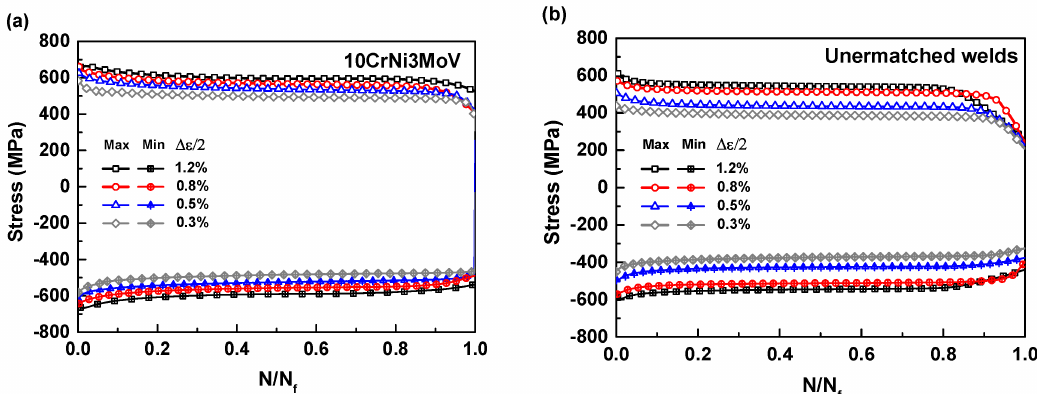
Figure 5. Evolution of the maximum and minimum stress with life ratio for different values of strain amplitudes: ( a ) 10CrNi3MoV steel; ( b ) Undermatched welds.